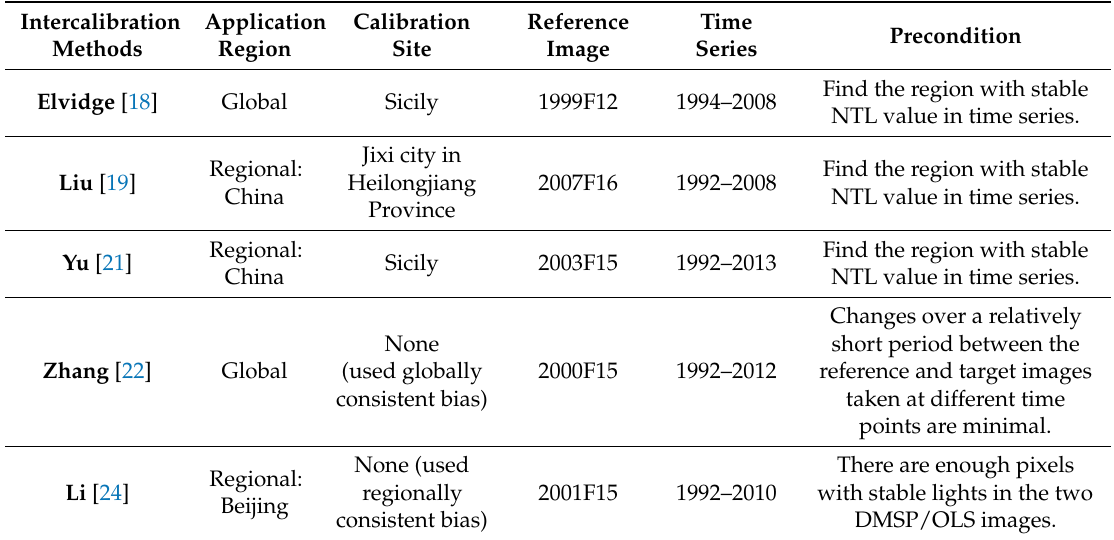
Table 2. Differences in the methodological details of existing intercalibration